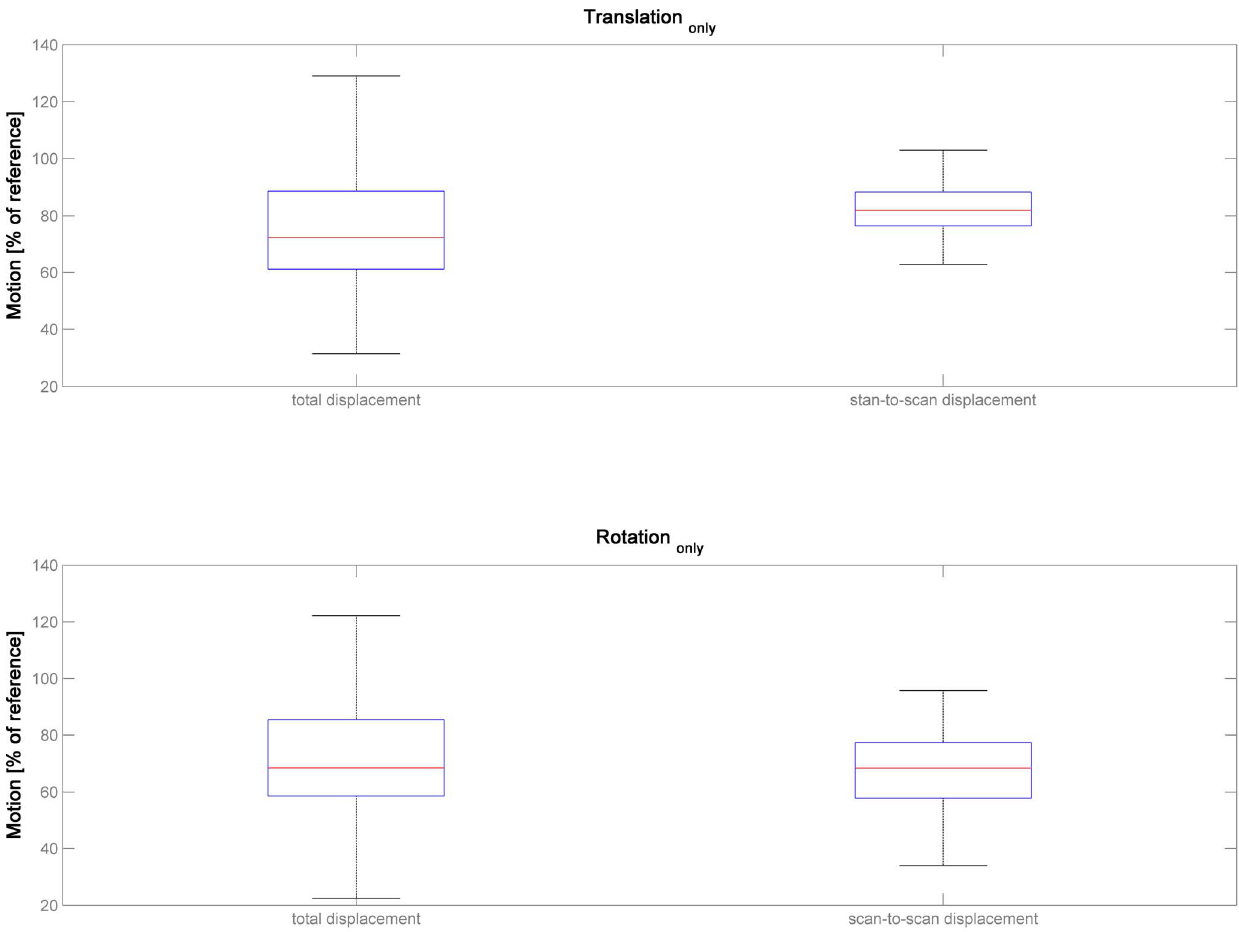
Figure 4. Illustration of estimated subject motion in dataset 3 (n=200) for the two reduced parameter sets (translation only , top panels, and rotation only , bottom panels), for both indicators (total displacement, left panels, and scan-to-scan displacement, right panels). Note severe underestimation of total subject motion when compared with the full parameter set (=100%).